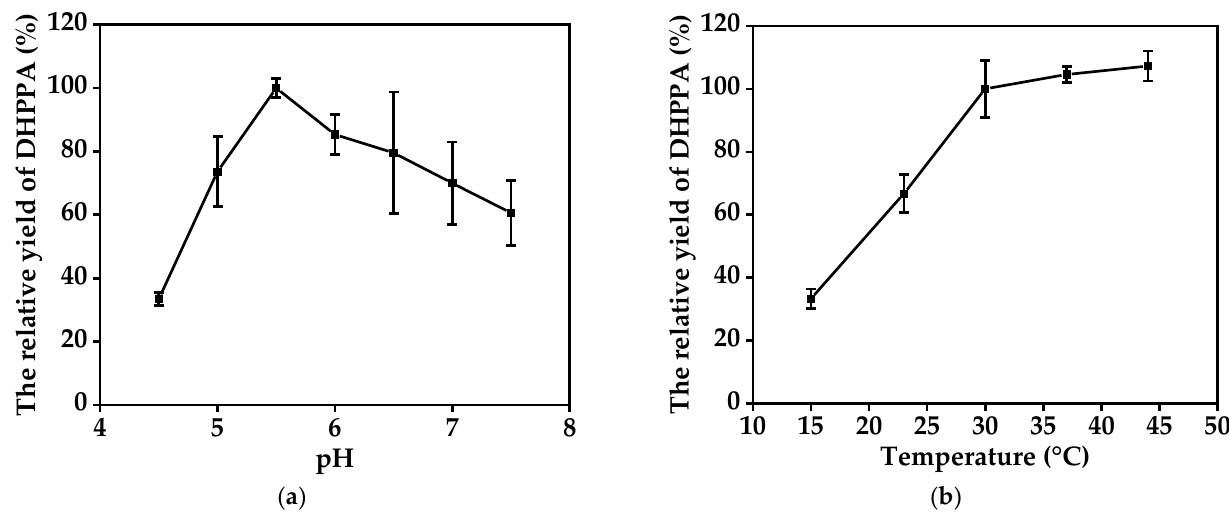
Figure 6. ( a ) Effects of pH on SAA production yield (the SAA yield at pH 5.5 was set as 100%). ( b ) Effects of temperature on SAA production yield (the SAA yield at 44 °C was set as 100%). Data represent the means ± SD from three independent determinations.